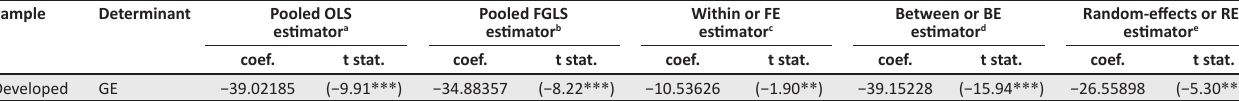
TABLE 9: Variation of Corruption Perceptions Index depends on government effectiveness, by stage of development: Developed. Sample Determinant